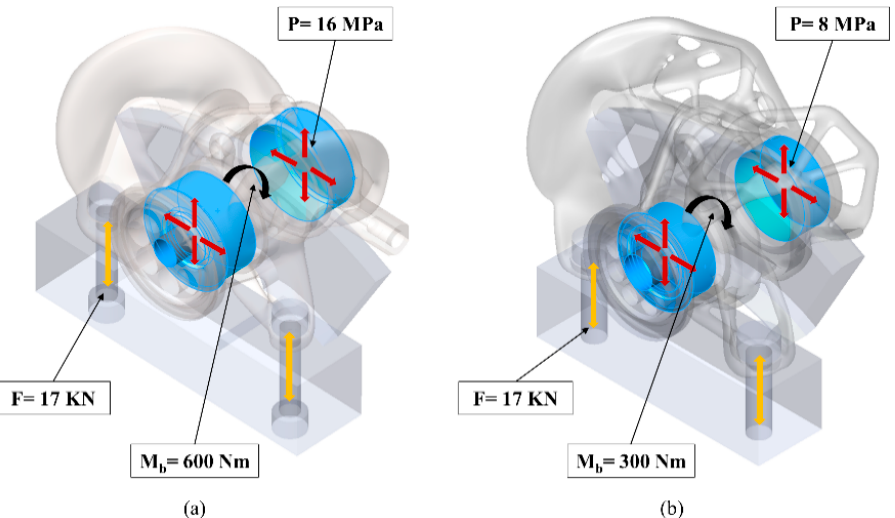
Figure 8. The used assemblies for the validation studies with their loads and boundary conditions: ( a ) Assembly of the front caliper, ( b ) Assembly of the rear caliper. ( a ) Assembly of the front caliper, ( b ) Assembly of the rear